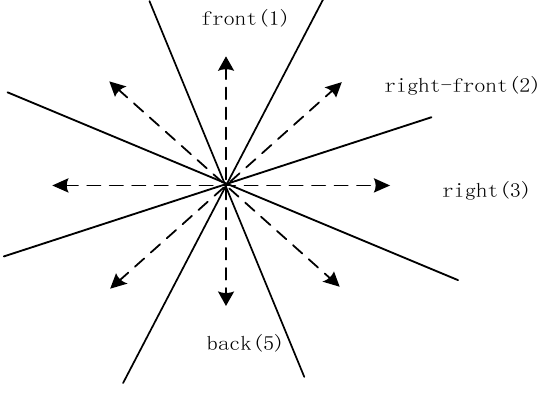
Figure 8 . Illustration of path ( Θ ) . The dashed lines are the centerlines of corresponding cones. Each centerline is assigned a number from 1 to 8 clockwise (e.g., front is assigned 1). The visual field can also be divided into four sectors, namely, “front, back, left, and right” or “north, south, west, and east.” Then, the fuzzy relative direction membership function changes to Equation (3):